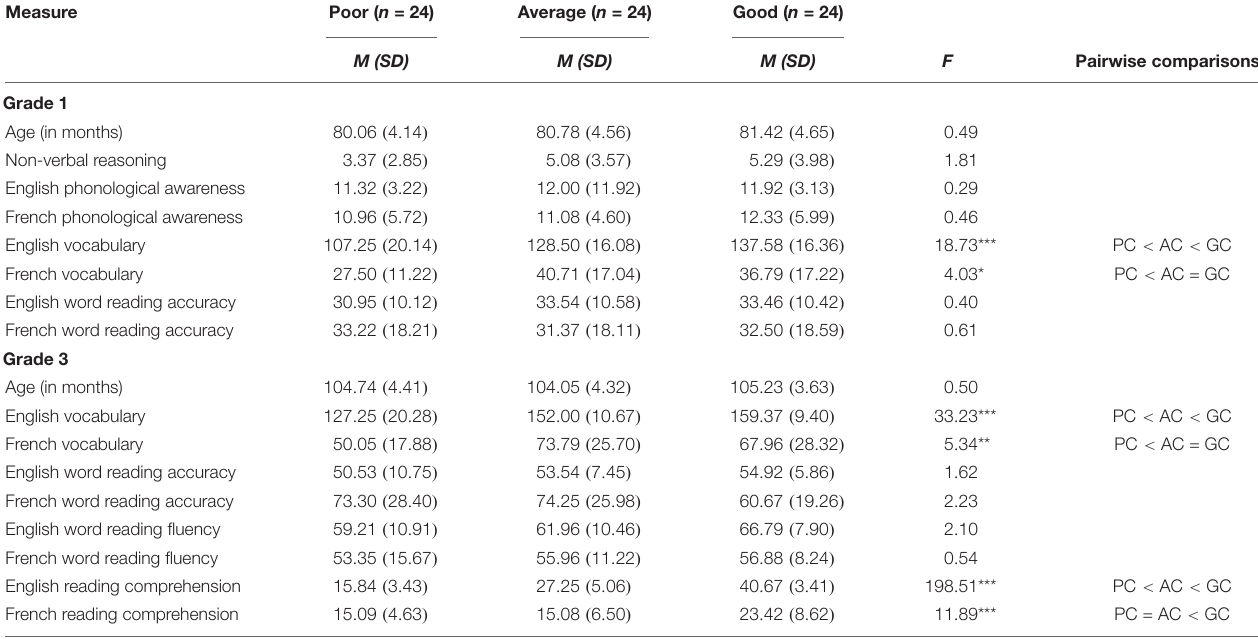
TABLE 2 | Means (standard deviations) of poor, average, and good comprehenders selected with English measures on English and French reading and language variables in grade 1 and grade 3.